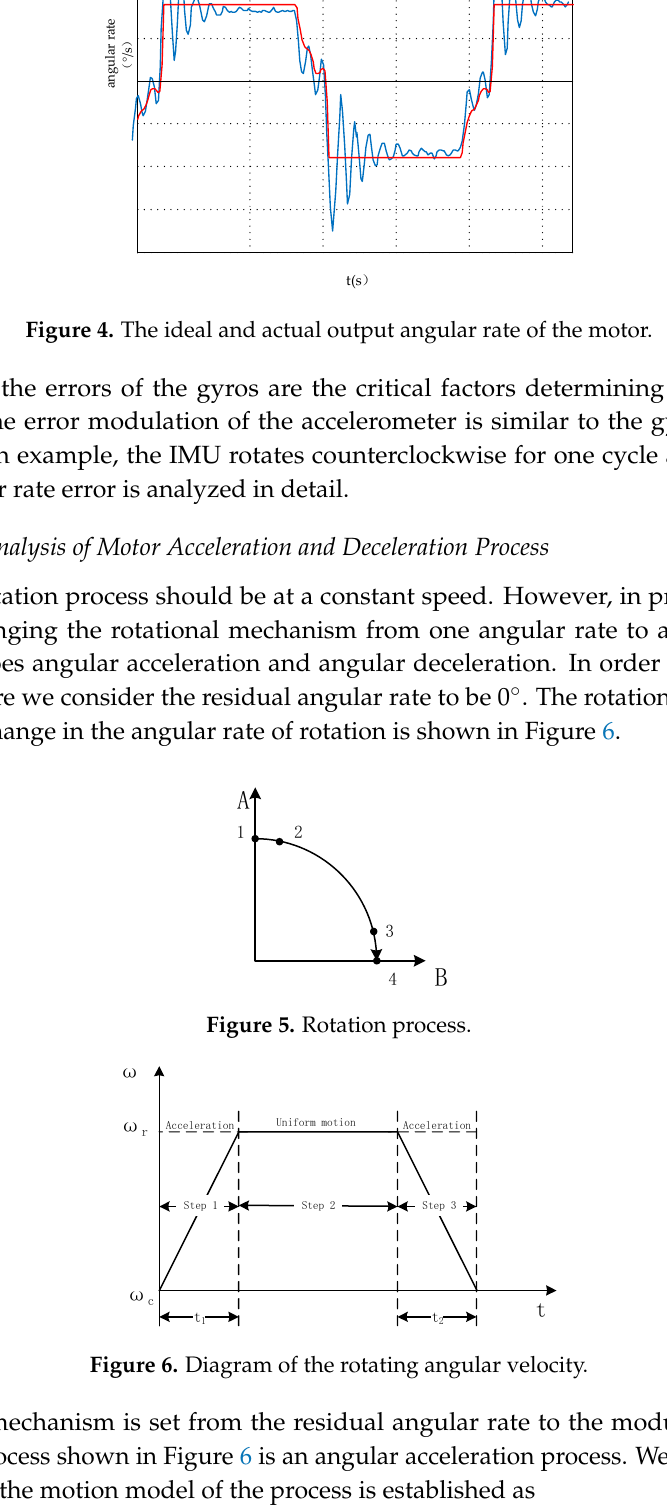
Figure 6. Diagram of the rotating angular velocity. The rotation mechanism is set from the residual angular rate to the modulation angular rate, that is, the 1 to 2 process shown in Figure 6 is an angular acceleration process. We assume that with 0° as the initial angle, the motion model of the process is established as 2 1